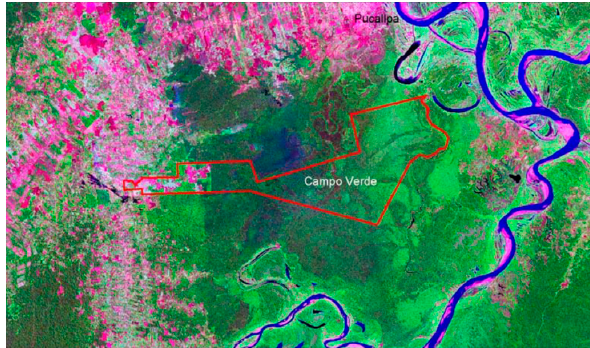
Figure 2. A Landsat image showing the locality of Campo Verde in relation to the town of Pucallpa. Note the deforestation surrounding the project (pink).